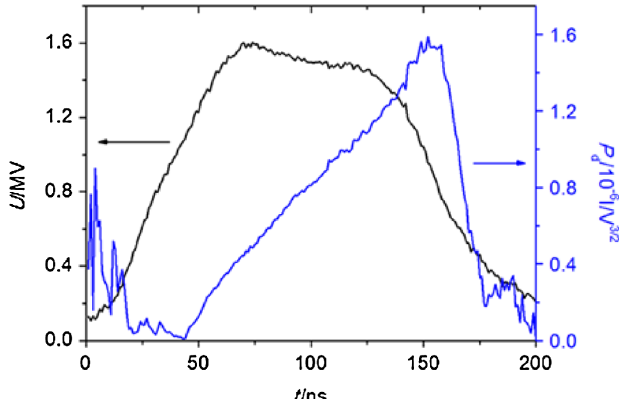
FIG. 5. Temporal variation of the voltage-current character- istics for the CNT cathode. Conditions: U ¼ 1 : 61 MV , I k ¼ 1 : 9 kA